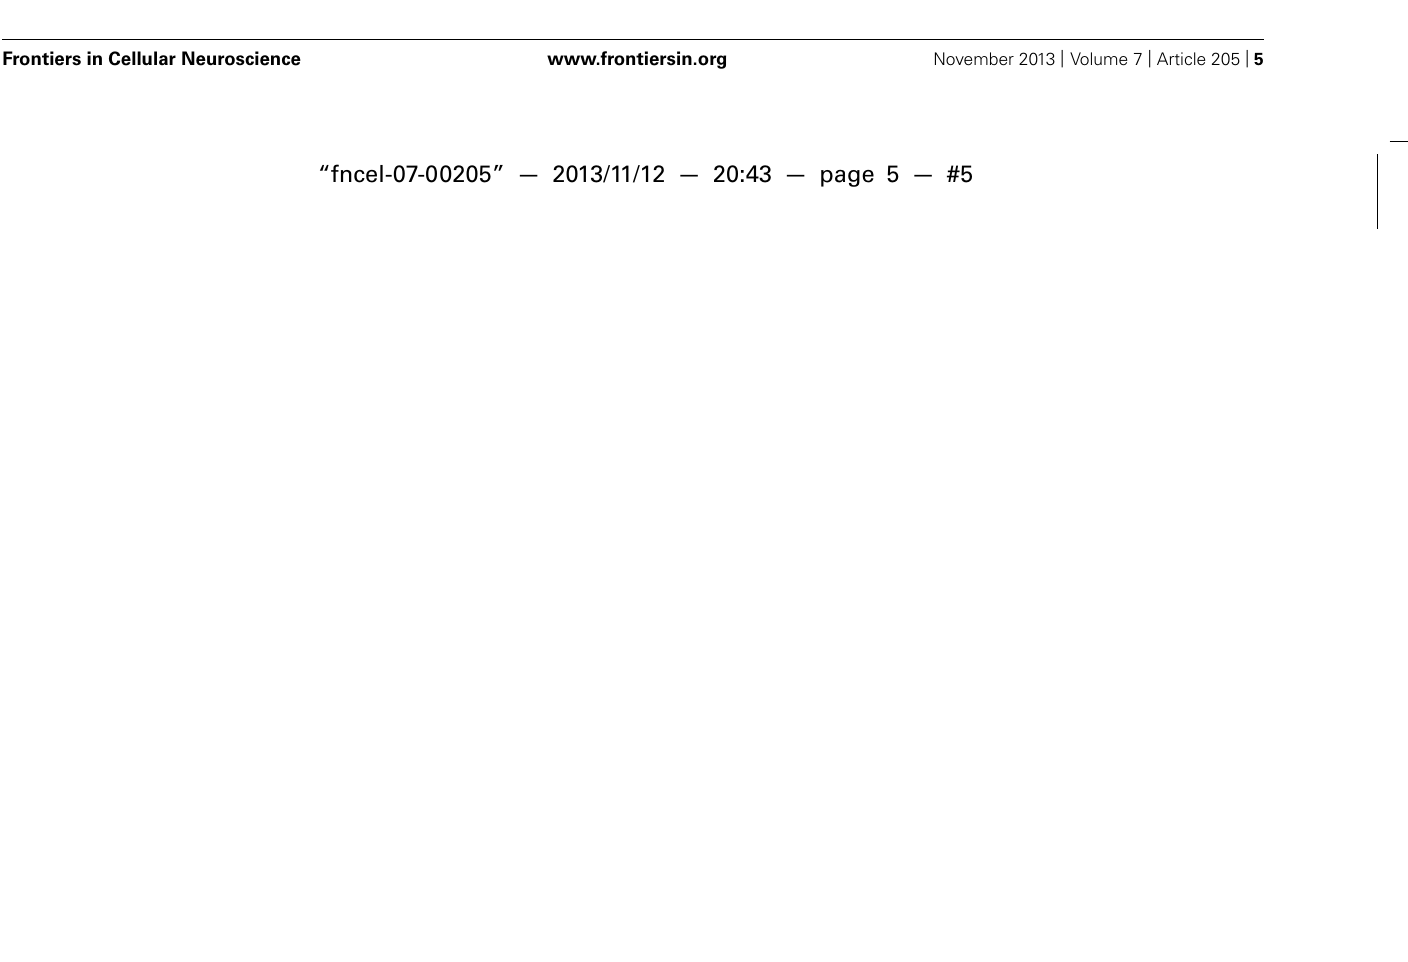
FIGURE 3 | Maturation of Kv3 expression during postnatal development. (A) Total capacitance (filled circles, measured with a 50-Hz sinus wave) and capacitance of soma and proximal dendrite (circles, measured with a 500 Hz sinus wave) versus postnatal age. (B) Capacitance of the clamped membrane